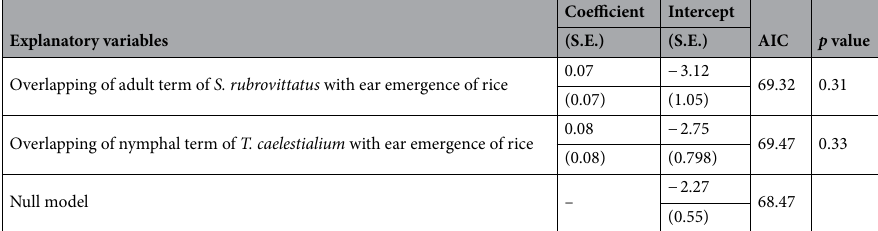
Table 3. Generalized linear mixed effects model (GLMM) for the occurrence of crop damage over the whole study term (2003–2013). Objective variables were occurrence of crop damage, explanatory variable were overlapping days. p value indicates the result for t-statistics using Satterthwaite’s method for denominator degrees of freedom.